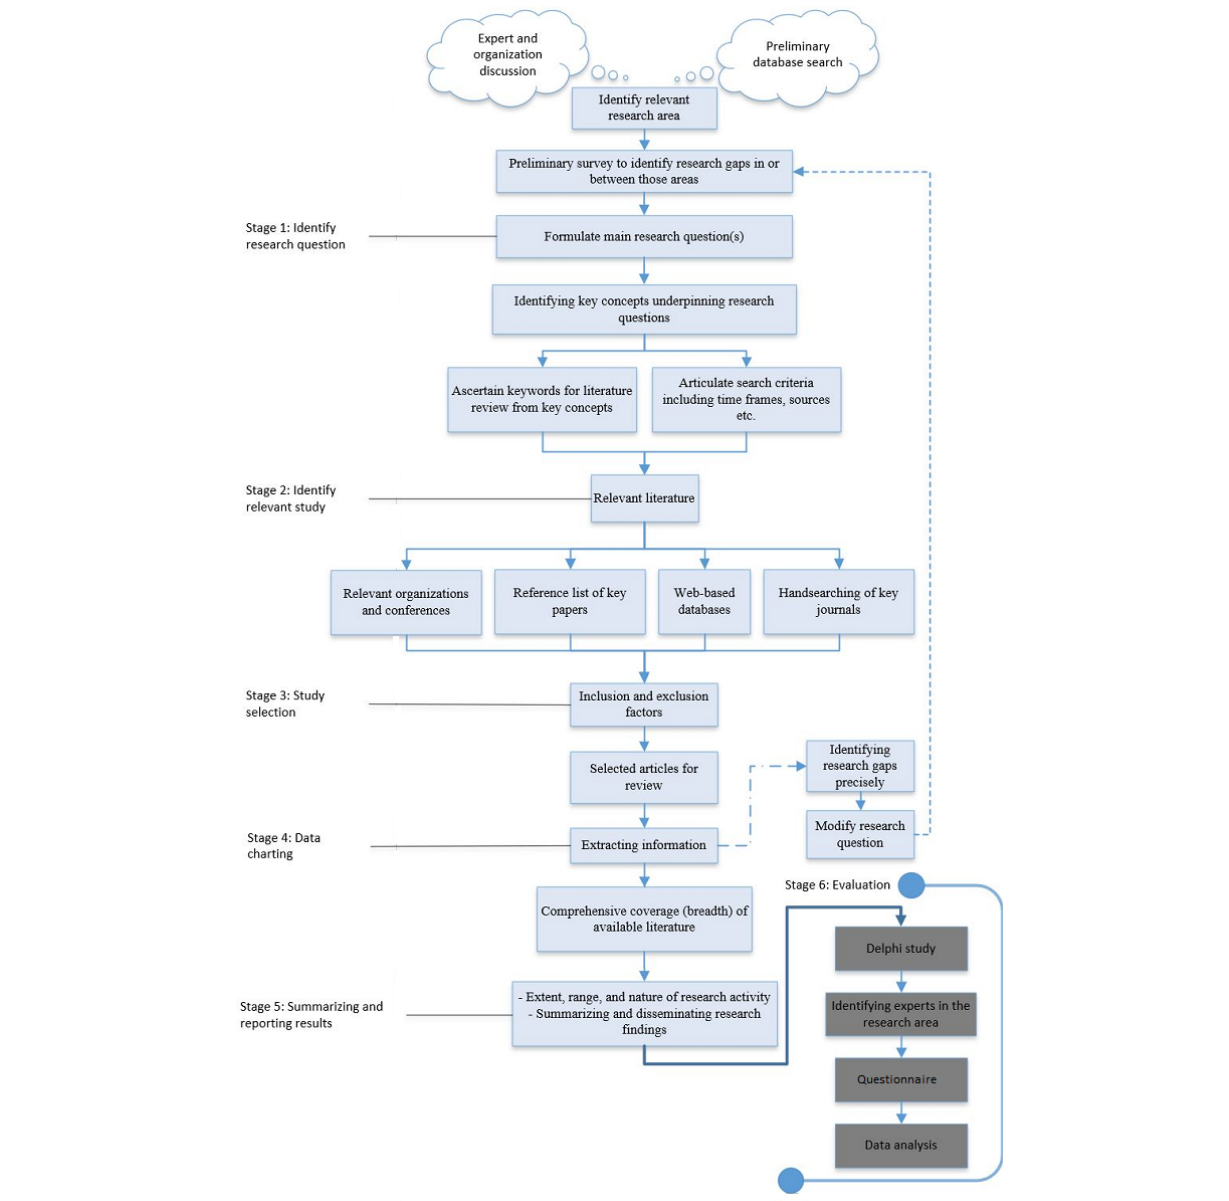
Figure 2. The scoping study framework for disaster